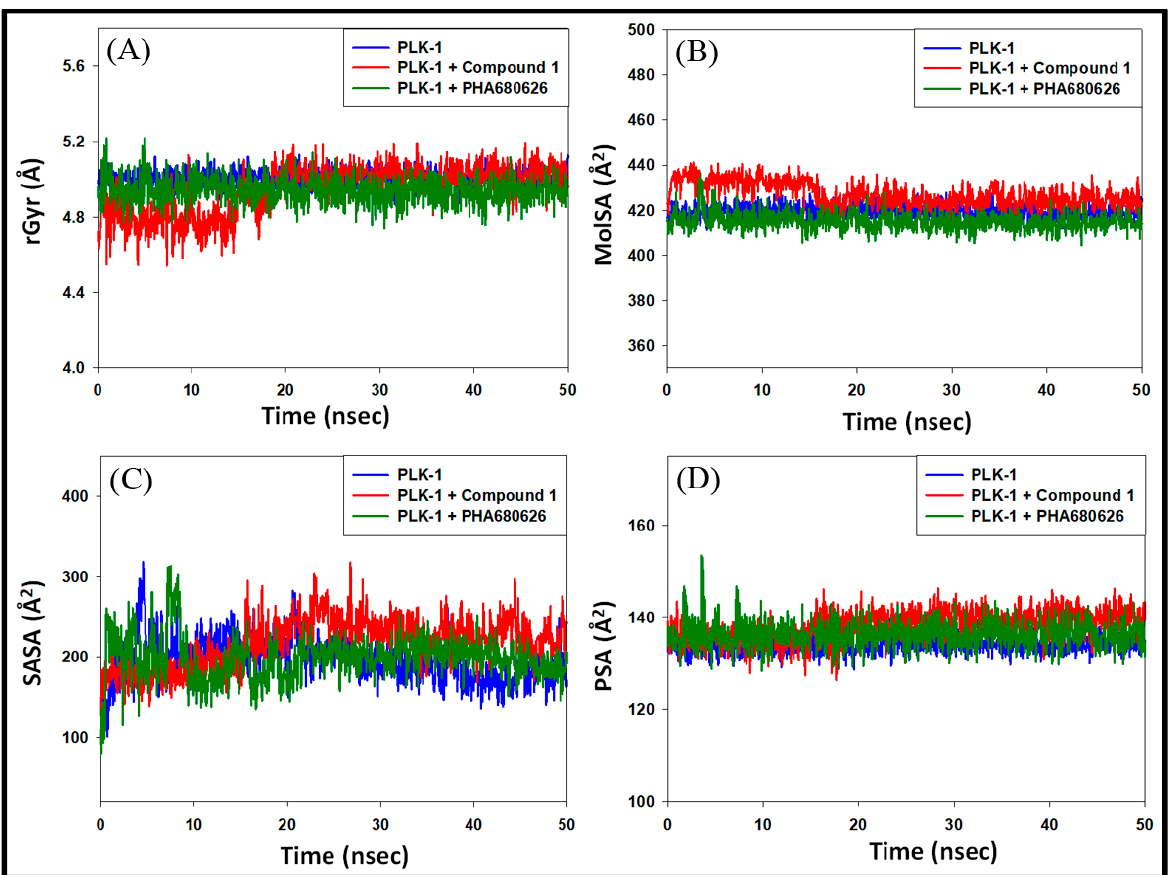
Figure 8. Dependency of ( A ) radius of gyration (rGyr), ( B ) molecular surface area (MolSA), ( C ) solvent accessible surface area, and ( D ) polar surface area of PLK-1, PLK-1-PHA680626 complex and PLK-1-compound 1 complex as a function of simulation.